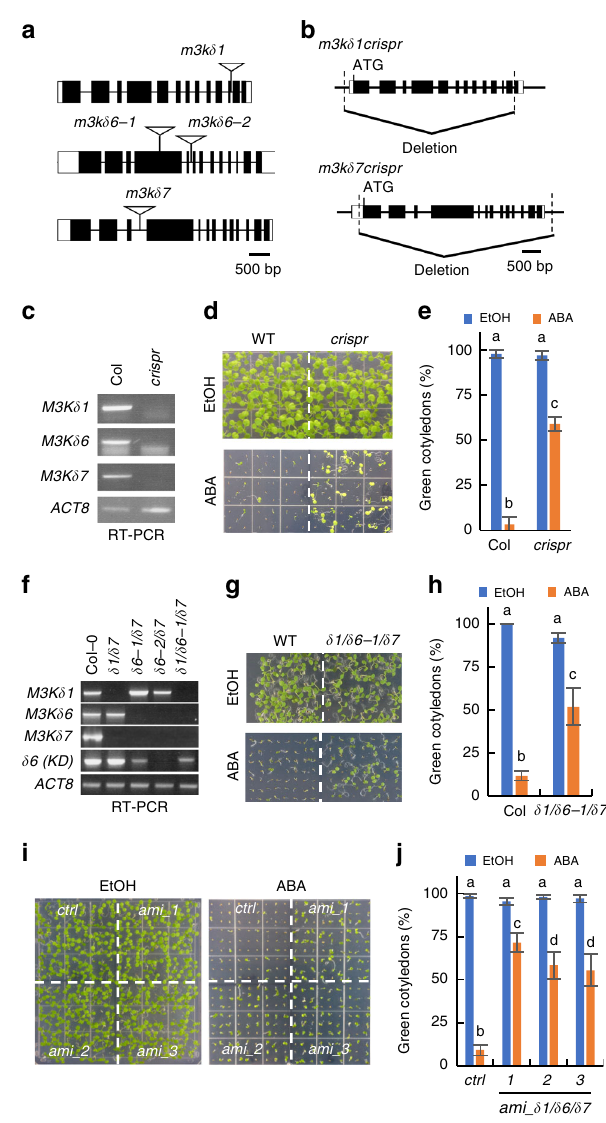
Fig. 5 MAPKK-kinases are required for plant ABA response. a Genome structures and T-DNA insertion sites of M3K genes are shown. b Genomic regions of CRISPR/Cas9-mediated M3K δ 1 and M3K δ 7 gene deletions are shown. These deletions were introduced in the m3k δ 6-2 T-DNA knockout mutant as a background. c RT-PCR assays show transcripts of kinase domains of M3Ks in the m3k δ 1crispr m3k δ 6-2 m3k δ 7crispr triple mutant. d m3k δ 1crispr m3k δ 6-2 m3k δ 7crispr triple mutant seedlings were grown on 1/2 MS plates supplemented with 2 µ M ABA or ethanol (control) for 16 days. e Seedlings showing green cotyledons as in d were counted. n = 3 (EtOH) and n = 4 (ABA) experiments, means±s.d., 45 seeds per genotype were used in each experiment. f RT-PCR shows M3K δ 1, δ 6 , and δ 7 expression in the indicated m3k T-DNA insertion mutants. δ 6(KD) refers to primers that amplify the M3K δ 6 kinase domain in the m3k δ 6-1 T-DNA line. g m3k δ 1 m3k δ 6-1 m3k δ 7 T- DNA triple mutant plants were grown on 1/2MS plates supplemented with 0.8 µ M ABA for 9 days. h Seedlings showing green cotyledons as in g were counted. n = 3, means±s.d., 60 – 88 seeds were used per genotype in each assay. i Three amiRNA lines targeting M3K δ 1, δ 6 , and δ 7 were grown on 1/ 2MS plates supplemented with EtOH (control) or 2 µ M ABA for 9 days. As a control line, the amiRNA-HsMYO line 21 was used. j Seedlings showing green cotyledons as in i were counted. n = 3 (EtOH) and 4 (ABA) experiments, means±s.d., 81 seeds per genotype were analyzed in each experiment. ( e , h , and i ) Letters at the top of columns are grouped based on two-way ANOVA and Tukey ’ s test, P